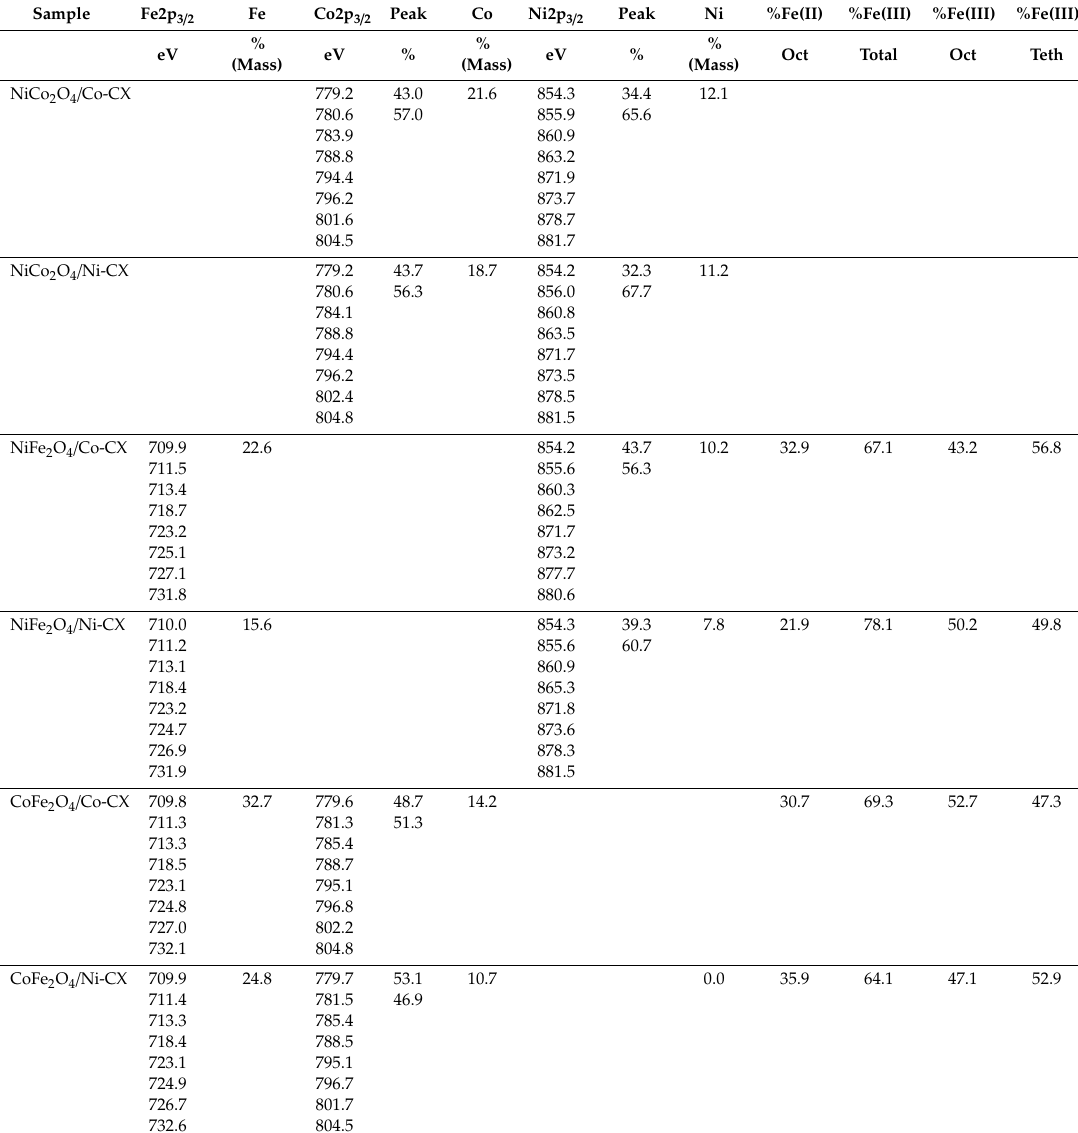
Table 4. XPS results collected after deconvolution of